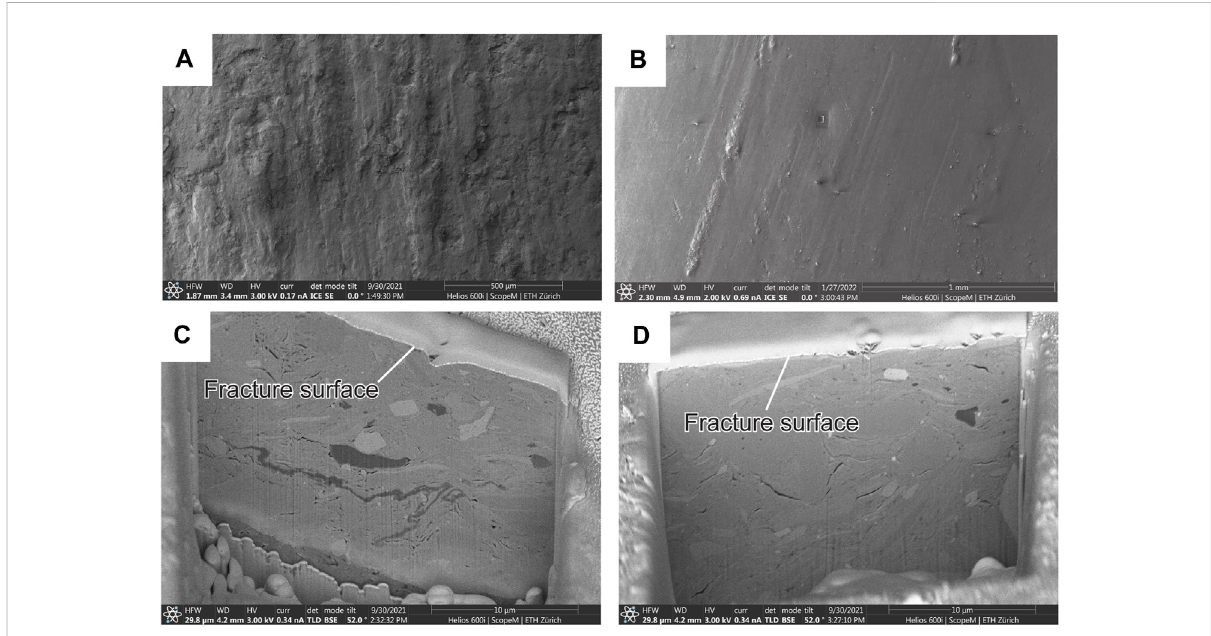
FIGURE 1 Focused Ion Beam investigations on OpalinusClay samples. (A) Secondary electron image(SEM) imageshowing thesurface of theslickensides fracturesurface. (B) Sameas (A) butfortheglassyfracturesurface. (C) Backscatterelectron(BSE)imagesowingacross-sectionperpendiculartothe slickenside fracture surface. (D) Same as (C) but for the glassy fracture surface.